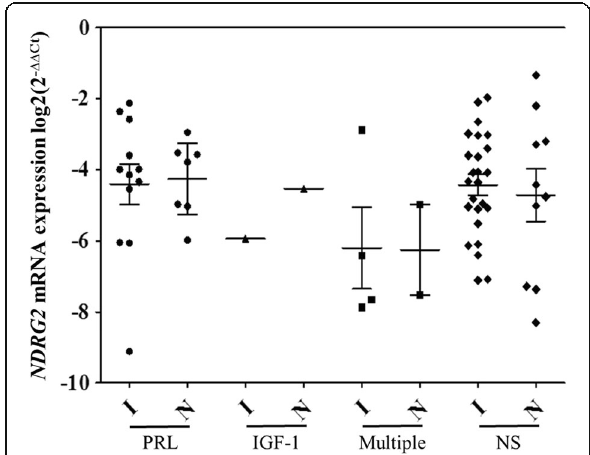
Fig. 4 Dot plot analysis of NDRG2 mRNA expression in invasive and noninvasive hormones of PAs. The horizontal bars represent the mean values with 95% confidence interval, the spots represent the amount of samples. PRL – prolactin, IGF-1 – insulin-like grow factor 1, multiple – PAs secreting more than one hormone, NS – non-secreting PAs; I –